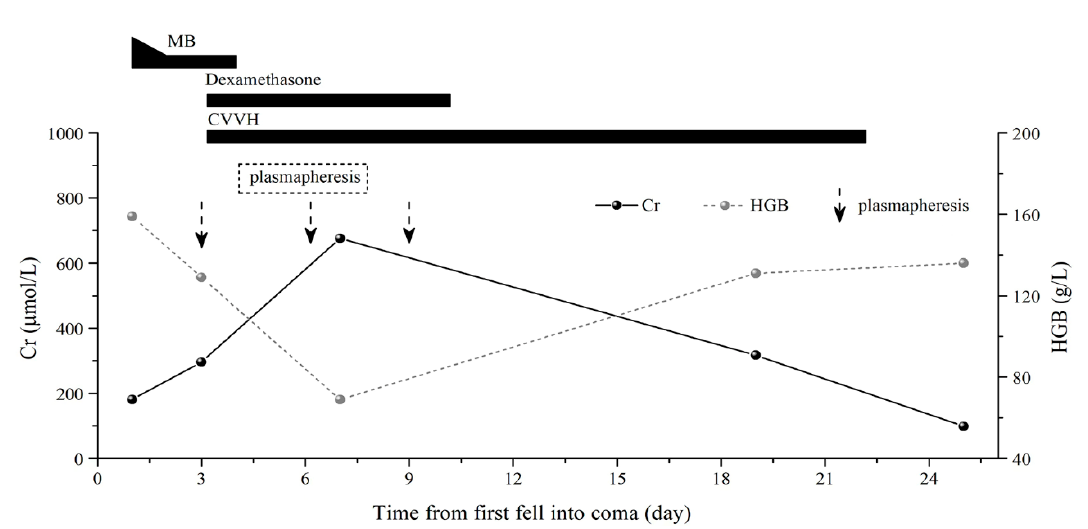
Figure 1. Clinical course of a patient with 5-amino-2-(trifluoromethyl)pyridine poisoning. MB, methylene blue; CVVH, continuous veno-venous hemofiltration.